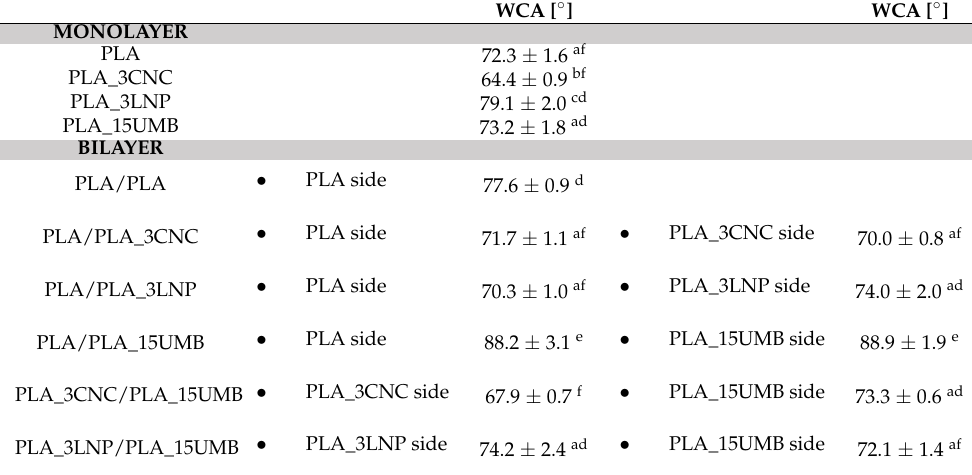
Table 3. Water contact angle (WCA) values of PLA (neat and nanocomposites) monolayer and bilayer